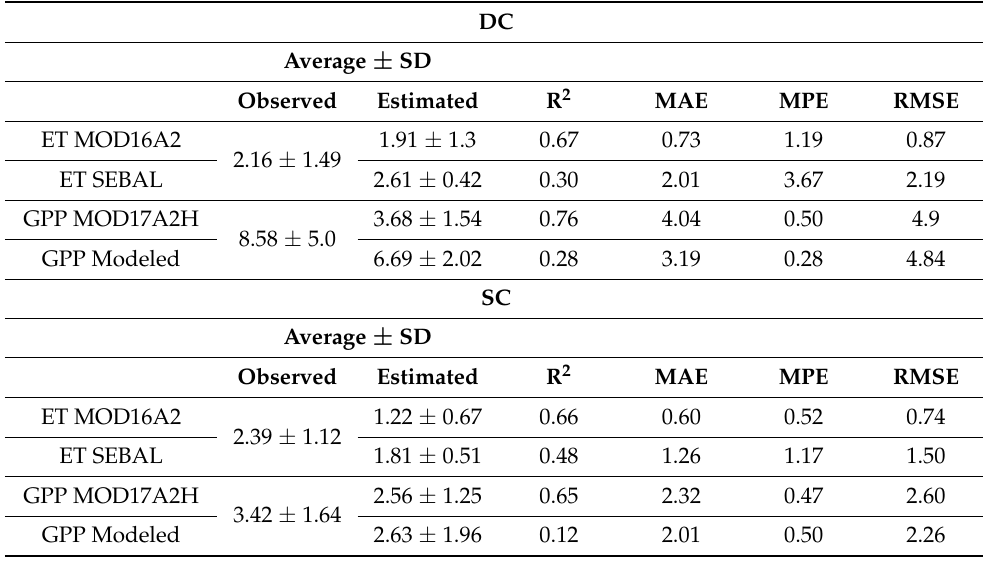
Table 2. Statistical analyzes for ET (MOD16A2 and SEBAL), in mm · d − 1 , and GPP (MOD17A2H and Modeled), in g · C · m − 2 · d − 1 , for the year 2013 in the DC and SC